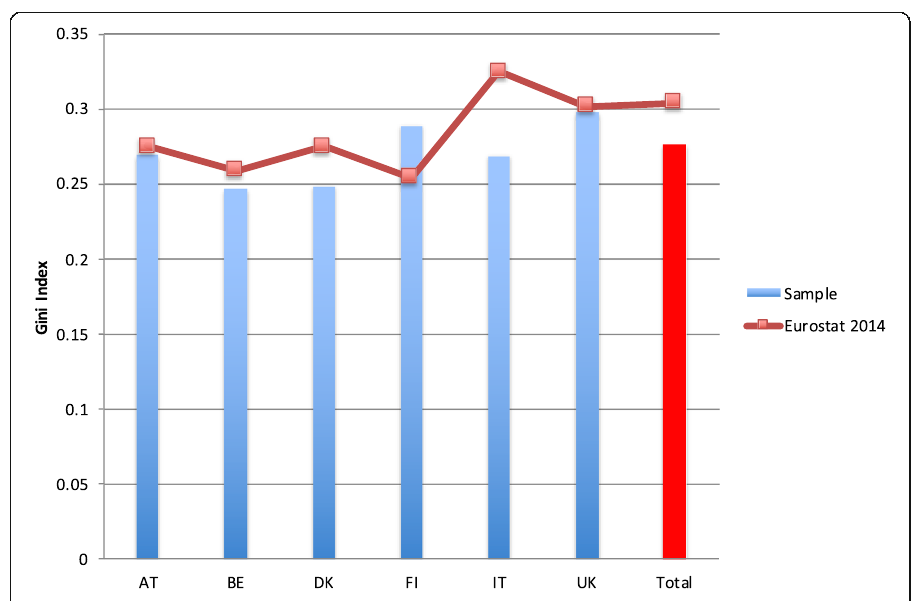
Fig. 2 Gini index for net income per